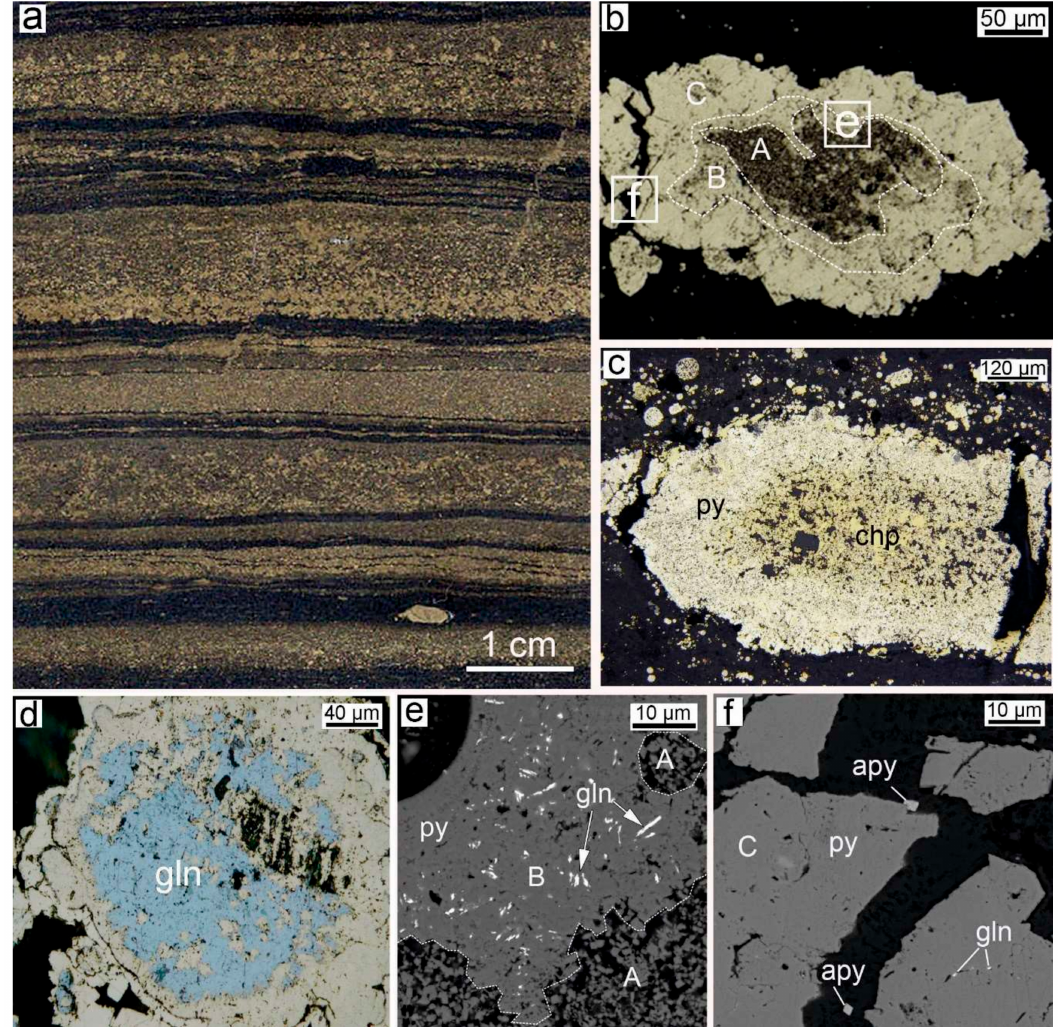
Figure 3. Pyrite nodules in sulfide–black shale diagenites of the Saf’yanovskoe deposit: ( a ) sulfide–black shale diagenite with intercalated sulfide and black shale layers, polished sample; ( b ) zoned pyrite nodule with the core (zone A), intermediate zone (zone B) and the rim (zone C); ( c ) replacement of fine-grained pyrite (py) from the core by chalcopyrite (chp); ( d ) replacement of the nodule by galena (gln); ( e ) numerous galena inclusions in zone B (detail of photo b ); ( f ) fragment of zone C with galena and arsenopyrite (apy) inclusions (detail of photo b ). Reflected light ( b – d ); SEM-photo ( e , f